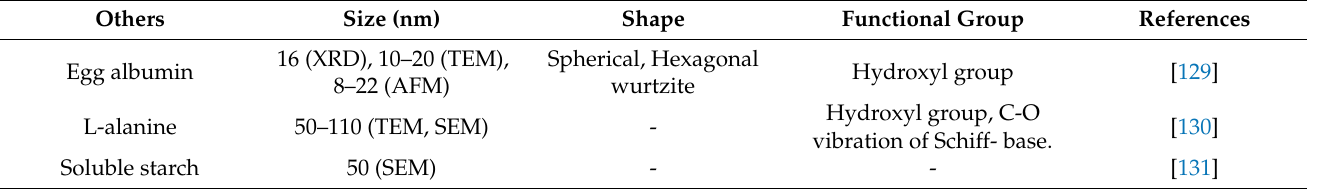
Table 5. Synthesis of ZnO-NPs by